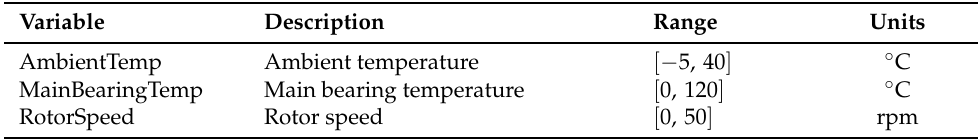
Table 4. Selected SCADA variables used to develop the anomaly detection model, its description, range of possible values, and units. All of them are related to the mean value over a 10-min